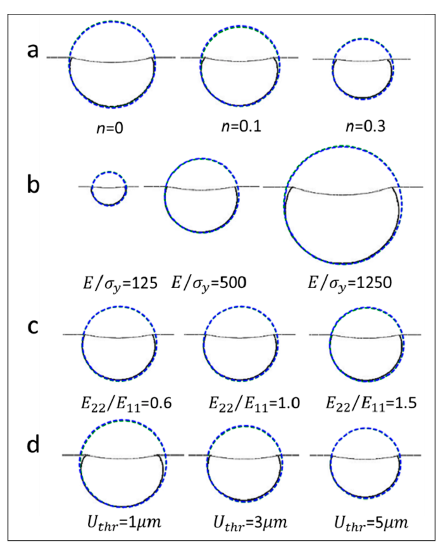
Figure 9. Influence of the strain hardening exponent, yield strain, elastic anisotropy, and the selected displacement threshold value on the shape of contour lines (for all the simulations in this figure, (cid:1844) (cid:2870)(cid:2870) is fixed at 1.0).